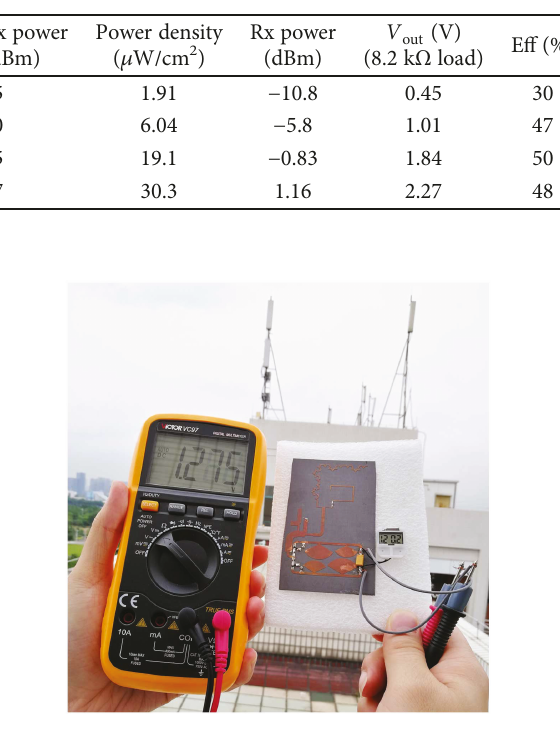
Table 2: Indoor measured results of the rectenna at 1 meter from Tx (Freq=1.85GHz, Tx antenna gain =8.8dBi, Rx antenna gain